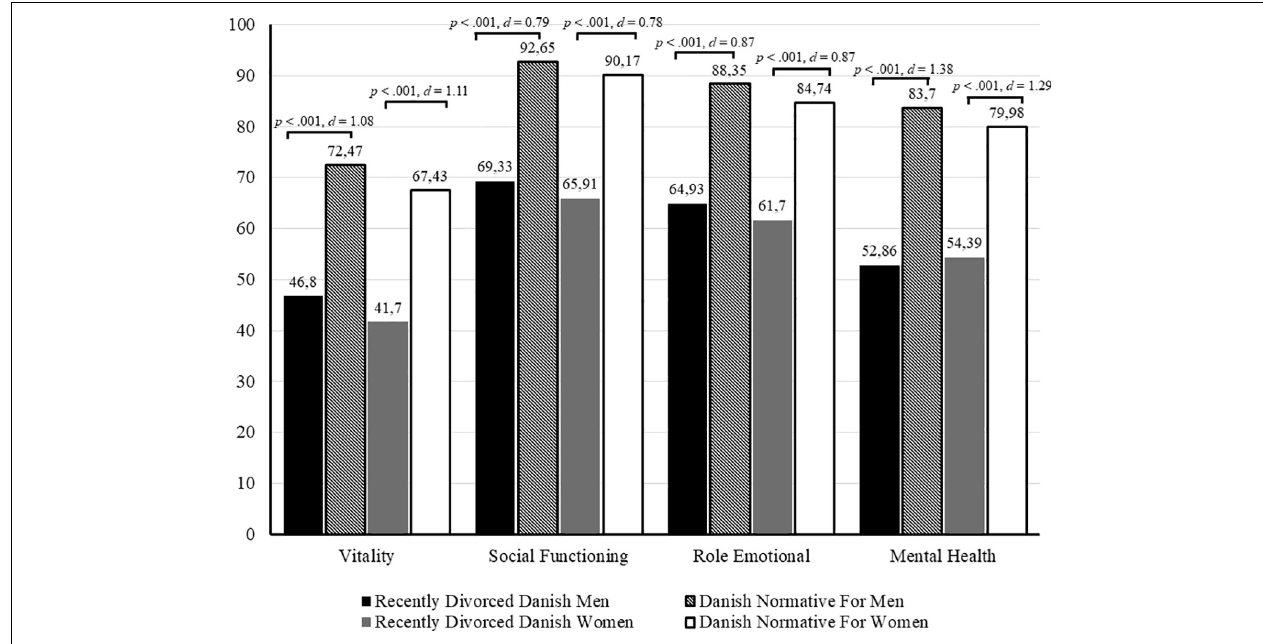
FIGURE 2 | SF-36 mental health domain means compared to normative